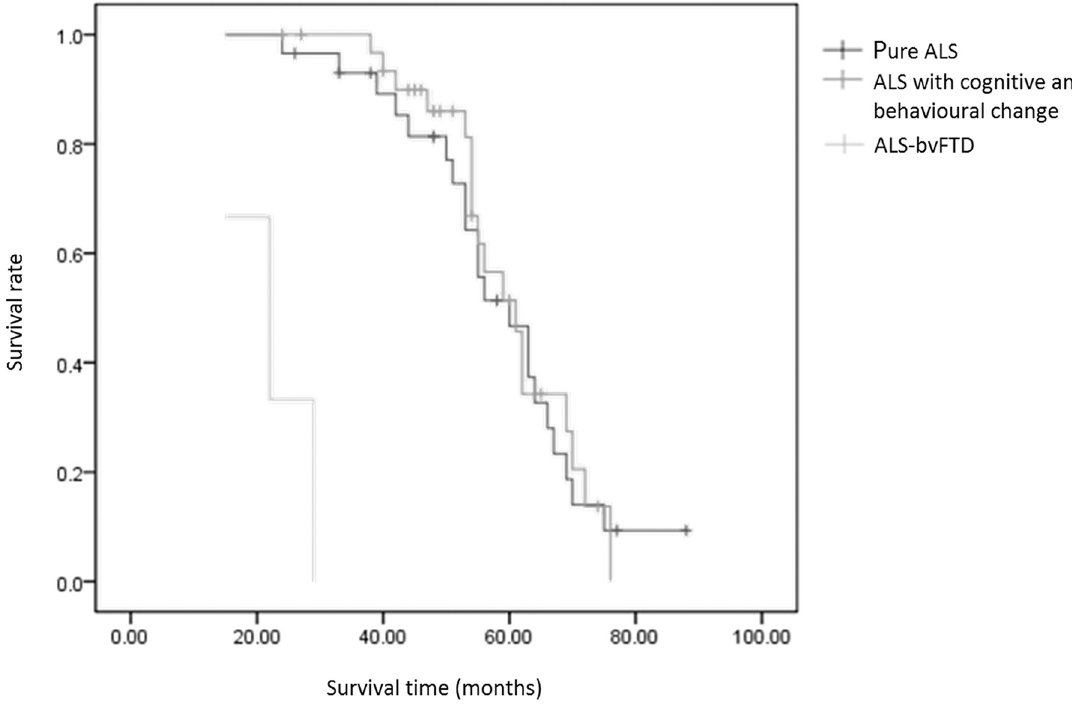
Fig 2. Survival analysis curve of ALS